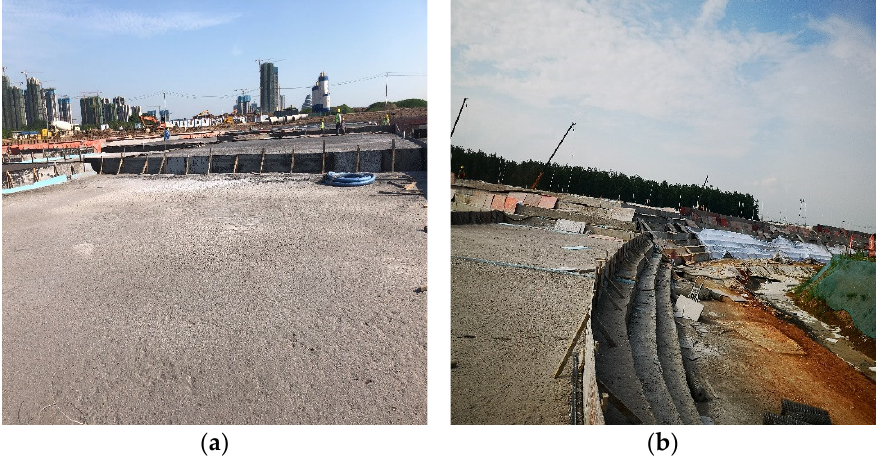
Figure 7. On-site pouring: ( a ) square or rectangular pouring unit and ( b ) pouring height with the wrong table at the edge of the road.